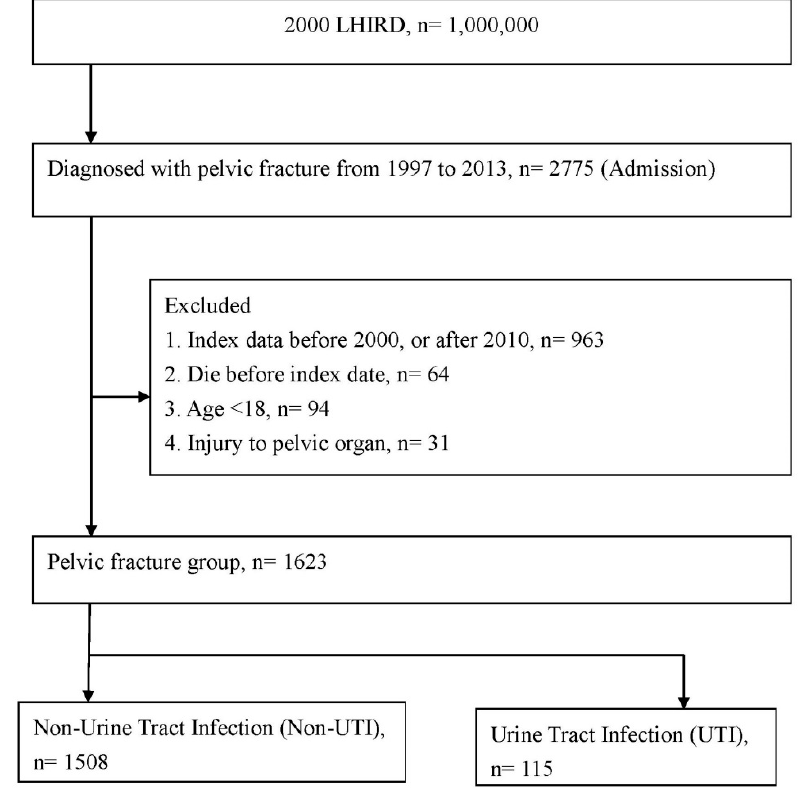
Figure 1. Flowchart for patient selection.